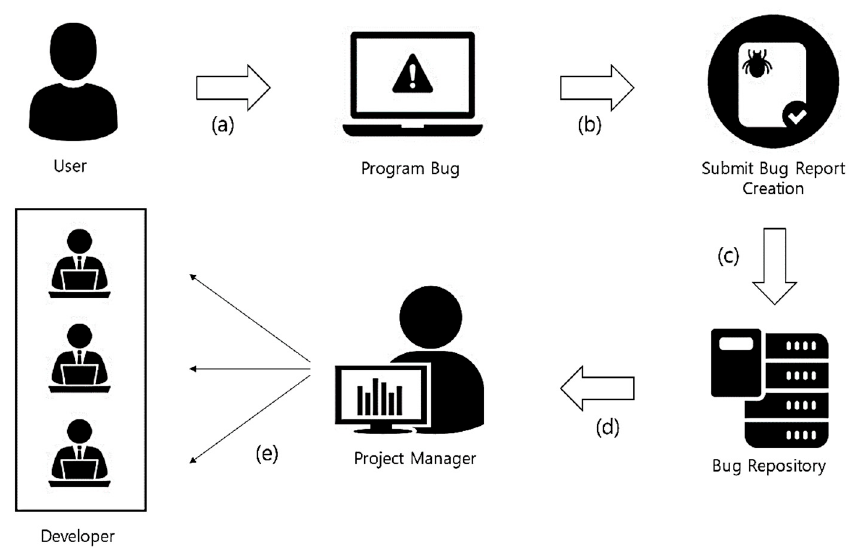
Figure 1. Developer Recommendation in Open Source Projects.